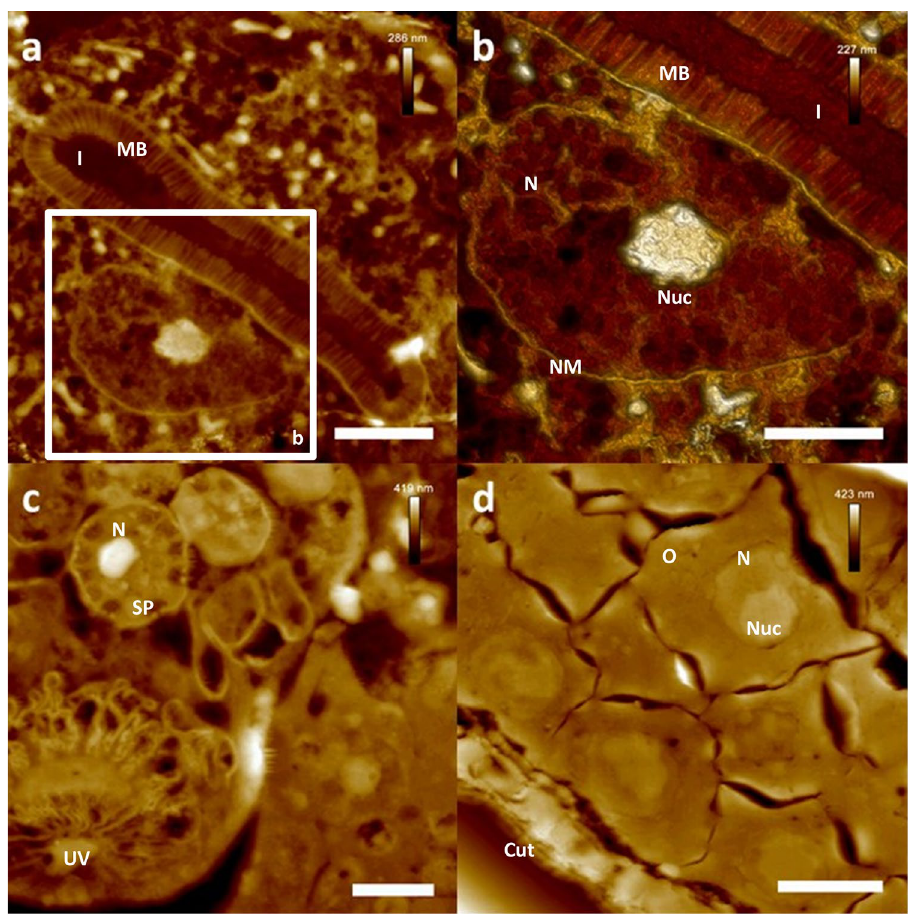
Figure 2. AFM-based ultrastructural analysis of Caenorhabditis elegans morphology. Nanoscopically resolved exemplary nematode tissues. ( a ) High resolution height data of two enterocytes forming the intestinal lumen. Note the clear resolution of single microvilli. ( b ) High resolution close up on nuclear region of a single enterocyte, showing ultrastructural details of the intranuclear composition. ( c ) High resolution height data of spermathecal tissue of C. elegans . Note the clear depiction of single spermatids ( c ). ( d ) Heigh resolution close up on gonadal tissue, showing single oocytes of the proximal gonads. Scale bars ( a ) and ( d ) 3 µm, ( b ) and ( c ) 2 µm. Cut cuticle, I intestinal lumen, MB microvilli brush, N nucleus, NM nuclear membrane, Nuc nucleolus, O oocyte, SP spermatid, UV uterine